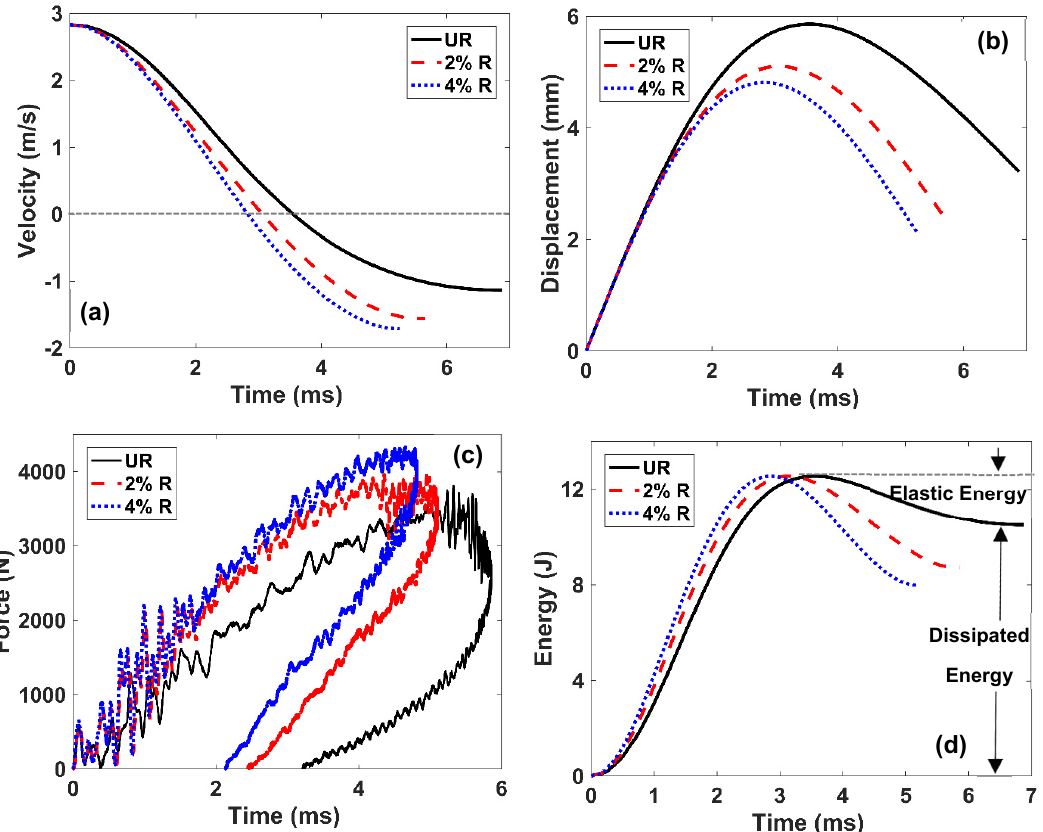
Figure 2. Various impact performance parameter curves at 12.5 J impact: ( a ) force–displacement; ( b ) velocity–time; ( c ) displacement–time; ( d ) energy–time.